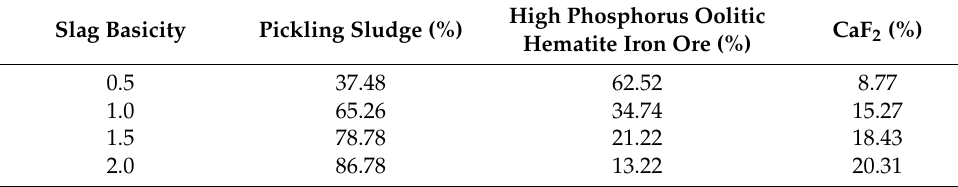
Table 1. The percentages of pickling sludge and high phosphorus oolitic hematite iron ore. Slag Basicity Pickling Sludge (%)